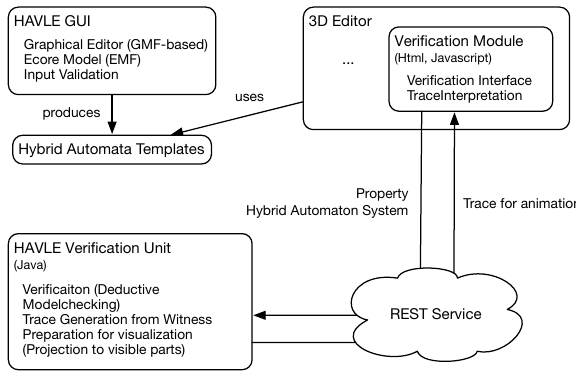
Figure 8. Components of the Verification Module